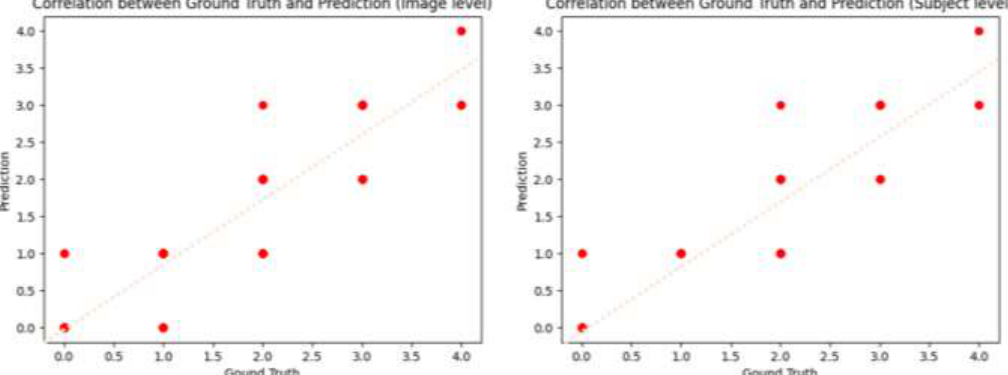
Figure 3. Spearman’s correlation between the predictions and the ground truth rating scales at image level ( left ) and at subject level ( right ) (at image level, all points (Gi, Pi) ∀ i = 1:576 and at subject level, all points (Gs, Ps) ∀ s = 1:96 were shown in the figure where G is the ground truth and P is the prediction. Spearman’s correlation coefficient of 0.9169 ( p -value < 0.0001) at subject level and 0.9335 ( p -value < 0.0001) at image level shows the reliability of the model estimation.